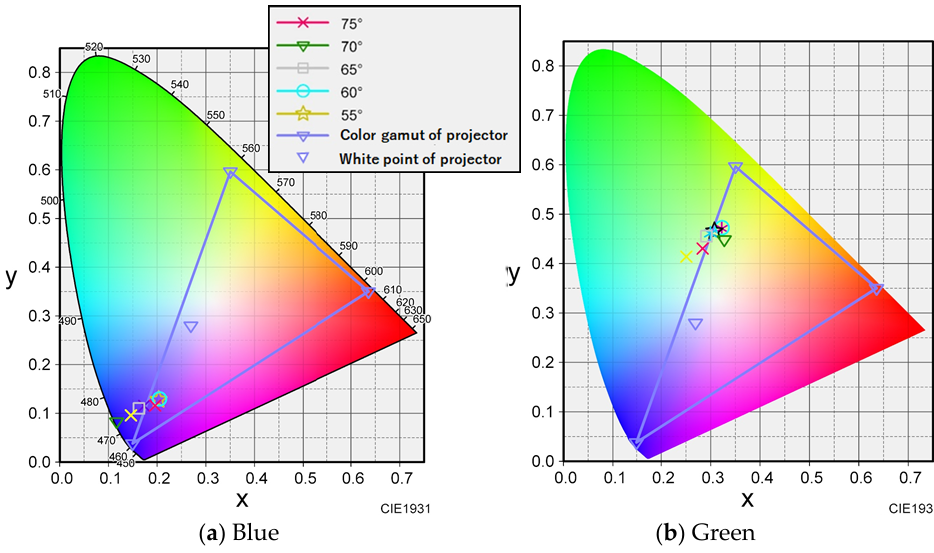
Figure 4. Color gamut of the projector and color-calibrated value for each angle. To select an appropriate number of reference points for each AIC, we created models with different numbers of reference points by selecting a few points from each measurement angle for comparison. The procedure for applying the AIC is as follows: